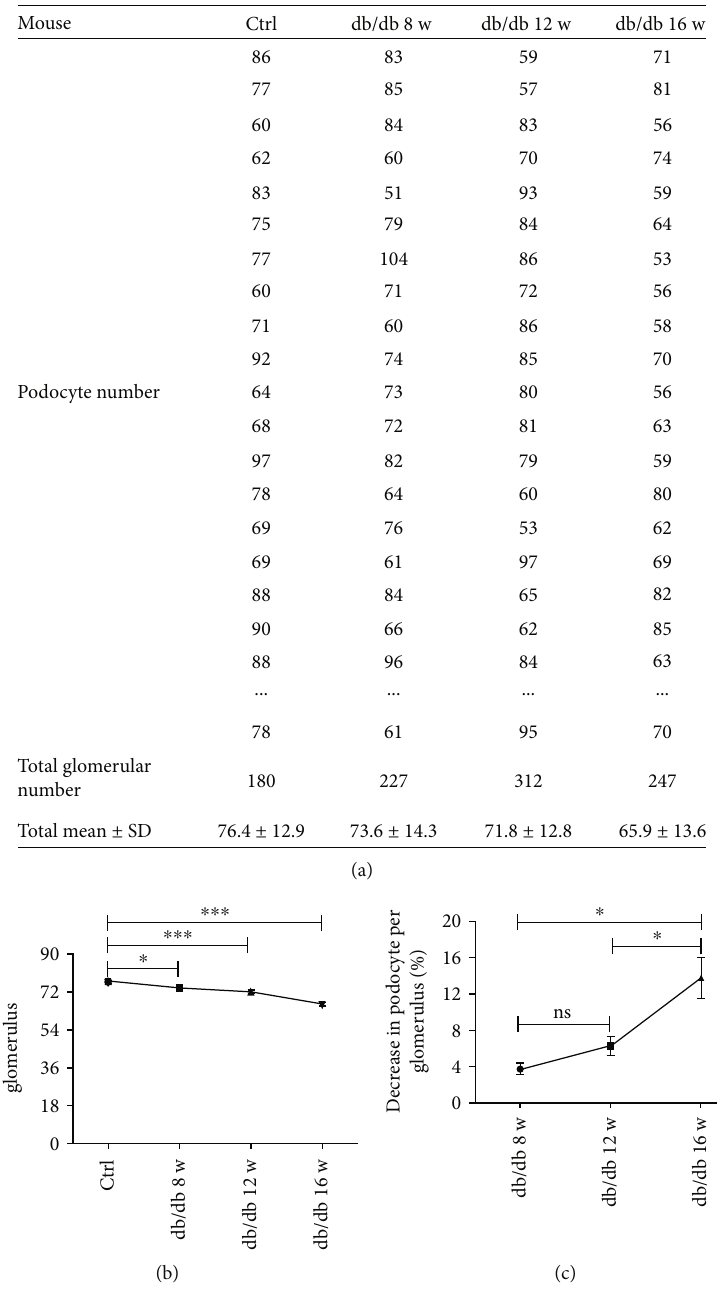
Figure 5: Absolute podocyte decrease of whole glomerulus in db/db mice. (a) The tabulation manifested podocyte number per glomerulus of the control group and db/db mice (three mice per group). The total podocyte number per glomerulus of every group was calculated through sum of all podocyte number divided by glomerular number of each group. (b) Statistically signi fi cant decrease in podocyte number per glomerulus in db/db mice indicated a more severe renal injury. Data are expressed as mean ± SEM . ∗ P < 0 : 05 , ∗∗∗ P < 0 : 001 , and ∗∗∗∗ P < 0 : 0001 for db/db mice by the age of 8 w, 12 w, and 16w versus the control group. (c) The decreased rate of podocyte number was expressed more noticeable in db/db mice in age of 16w, compared with those in age of 8w and 16 w. The decreased rate of podocyte number was calculated through the di ff erence of mean podocyte number per glomerulus between each db/db mice (at least 70 glomeruli per mouse) and the control group divided by mean podocyte number per glomerulus in the control group (180 glomeruli). Data are expressed as mean ± SEM . ∗ P < 0 : 05 , ns: no signi fi